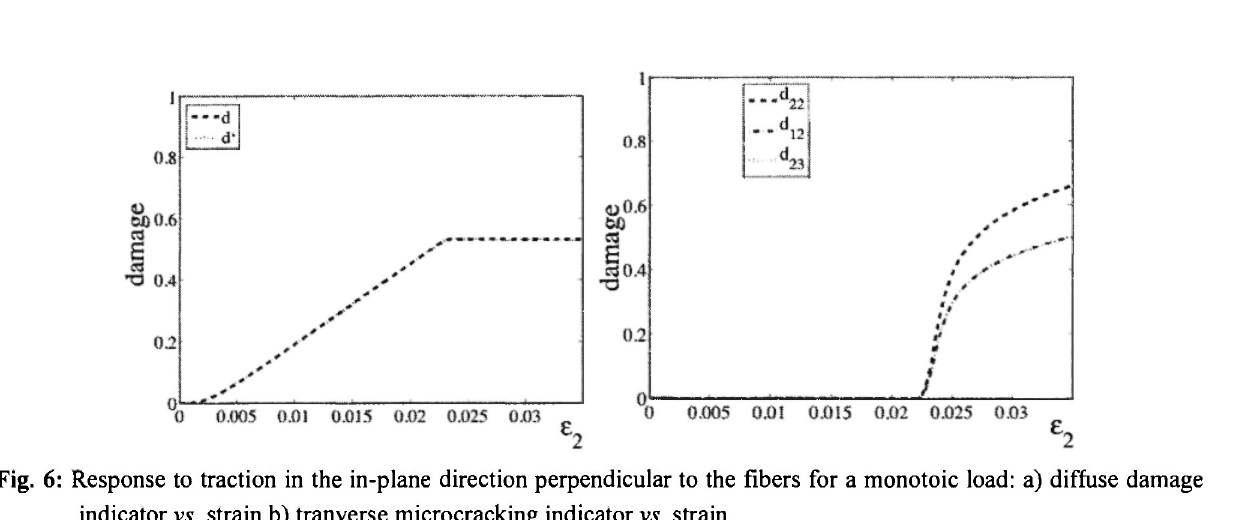
Fig. 6: Response to traction in the in-plane direction perpendicular to the fibers for a monotoic load: a) diffuse damage indicator vs. strain b) tranverse microcracking indicator vs.